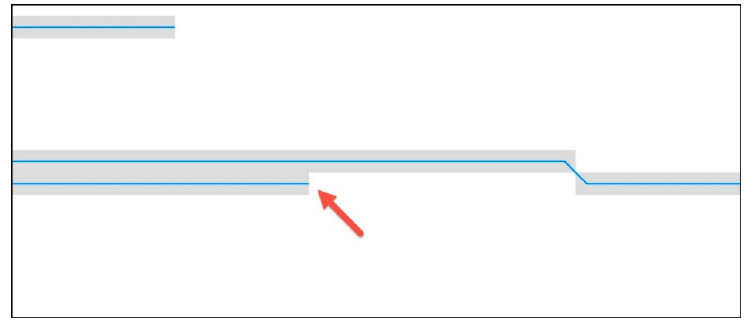
Figure 2. An undesirable situation according to the LaST approach: a drainage line whose cells are all adjacent to the cells of another drainage line.